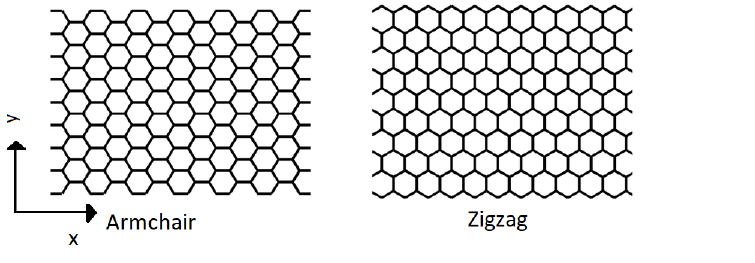
Figure 15. Armchair and zigzag graphene